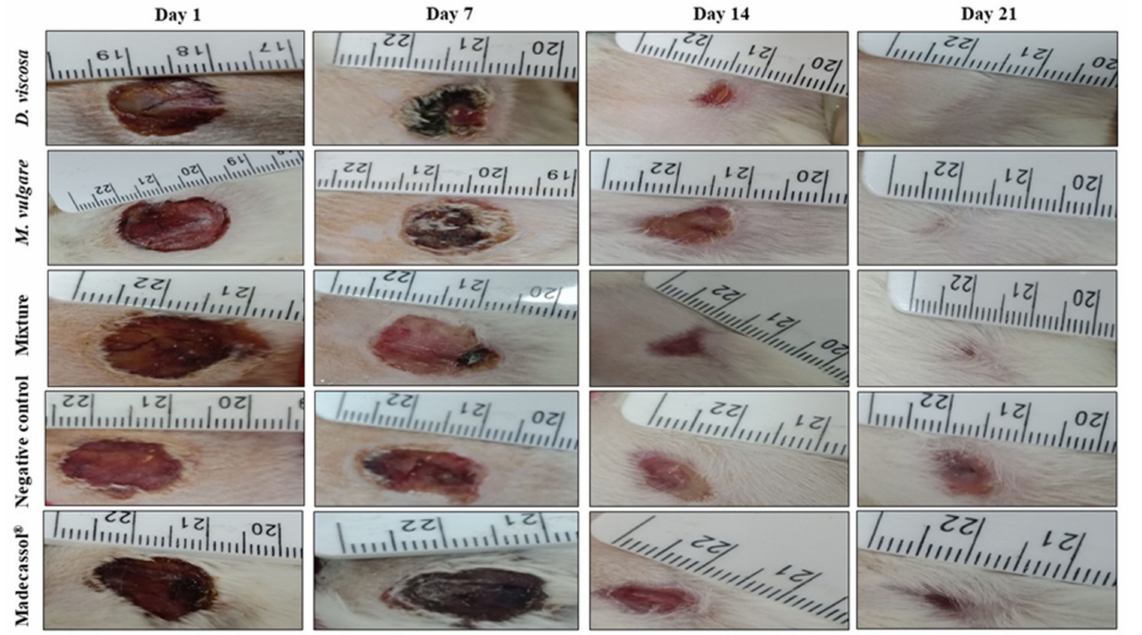
Figure 5. Aspect and photographical representation of burn healing process and morphological appearance of the wounds in groups treated with M. vulgare , D. viscosa , the mixture, and the control group from day 1 until day 21.